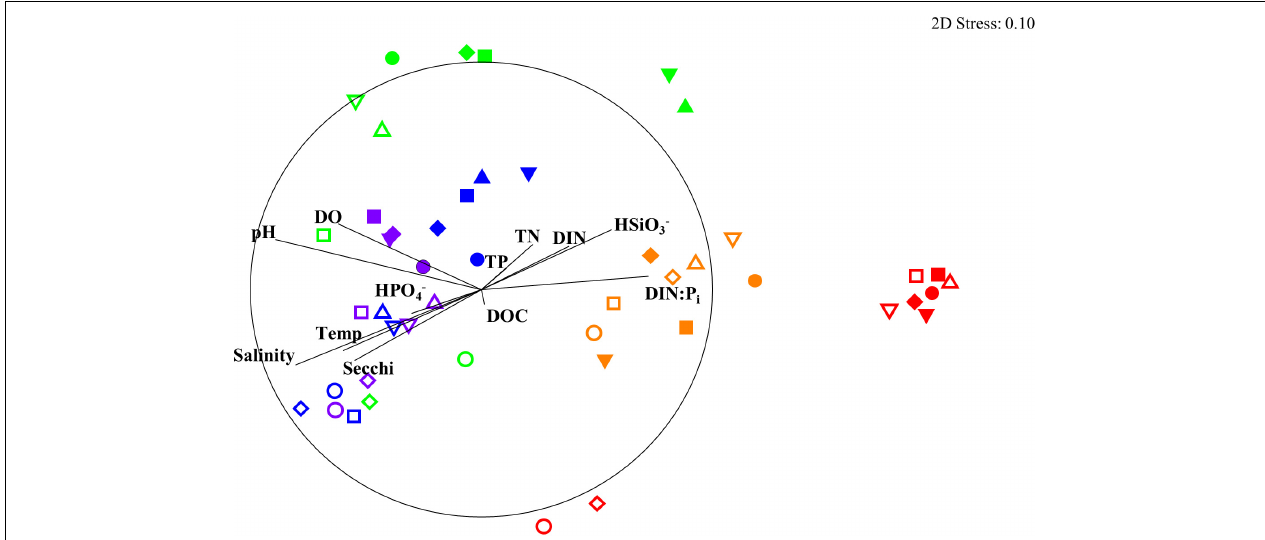
FIGURE 9 | nMDS of biological community showing Pearson correlation of environmental parameters as Temp: temperature ( ◦ C), Sal: salinity, DO: dissolved oxygen (mg L - 1 ), DIN: dissolved inorganic nitrogen ( µ M), DIN:Pi: dissolved inorganic nitrogen to phosphate ratio, TN: total nitrogen ( µ M 1 ), TP: total phosphorus ( µ M), DOC: dissolved organic carbon ( µ M). Stations are shown as differing symbols: Station 1 (closed upward triangle), 2 (closed downward triangle), 3 (closed square), 4 (closed diamond), 5 (closed circle), 6 (open upward triangle), 7 (open downward triangle), 8 (open square), 9 (open diamond), 10 (open circle). Time points are differentiated by color T1 (red), T2 (orange), T3 (green), T4 (blue), and T5 (purple). nMDS constructed from square root transformed values from the 16S and 18S rRNA OTU abundance data that were used to construct a Bray–Curtis similarity matrix. The circle represents a Pearson correlation of